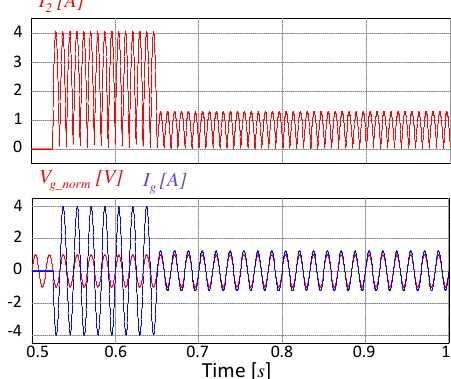
Figure 22. Zoom of the currents in the interval 0.5 s to 1 s —the current in the inductor L 2 , I 2 and the voltage and current of the grid V grid and I grid